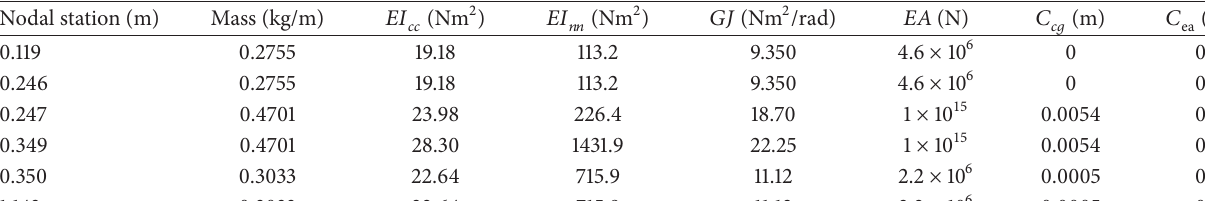
Table 1: Structural parameters for the “Mach Scale” rotor.